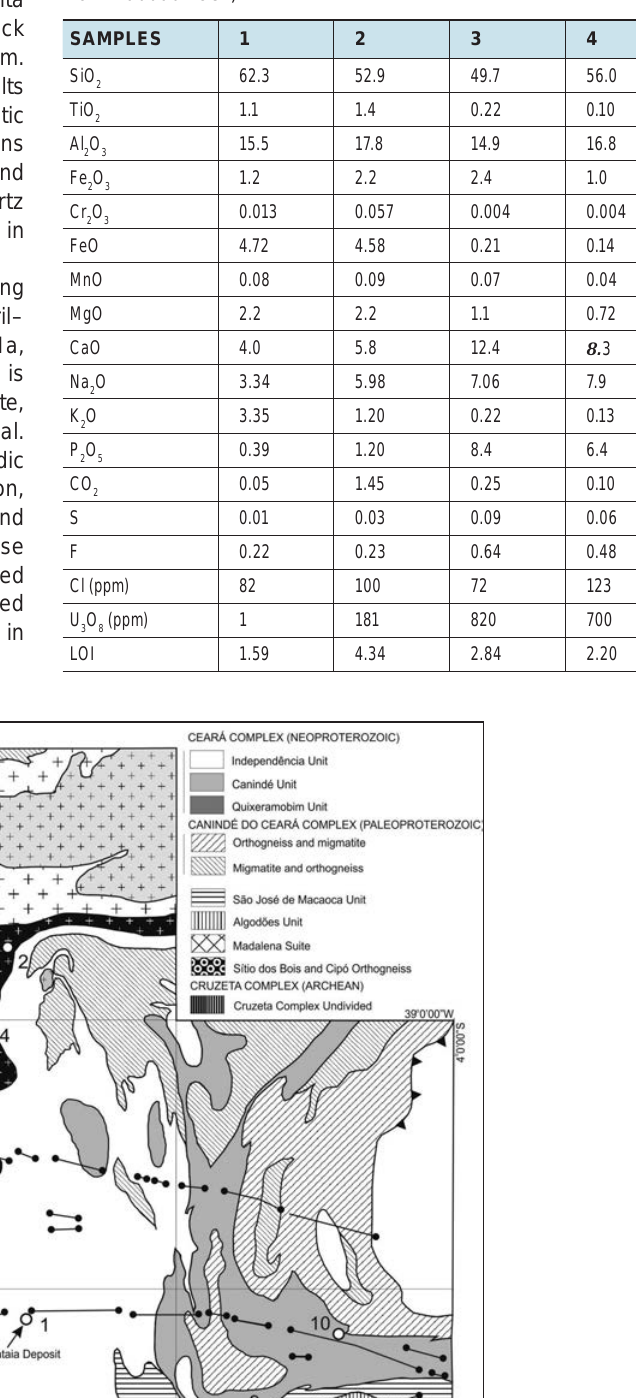
Table 1 - Chemical composition (in %) of (1) granitoid, (2) partially altered granitoid, and (3 and 4) albitites of the Taperuaba prospect, indicating the mineralogical changes due to albitization (compiled from Haddad